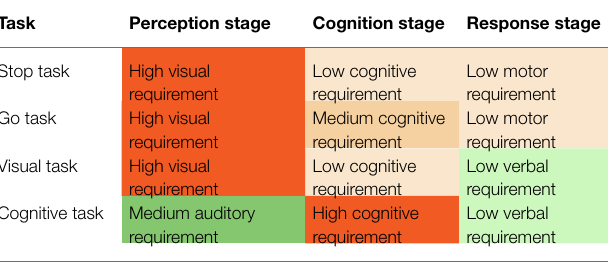
TABLE 1 | Modalities and amount of required resources for the road crossing and the secondary tasks.